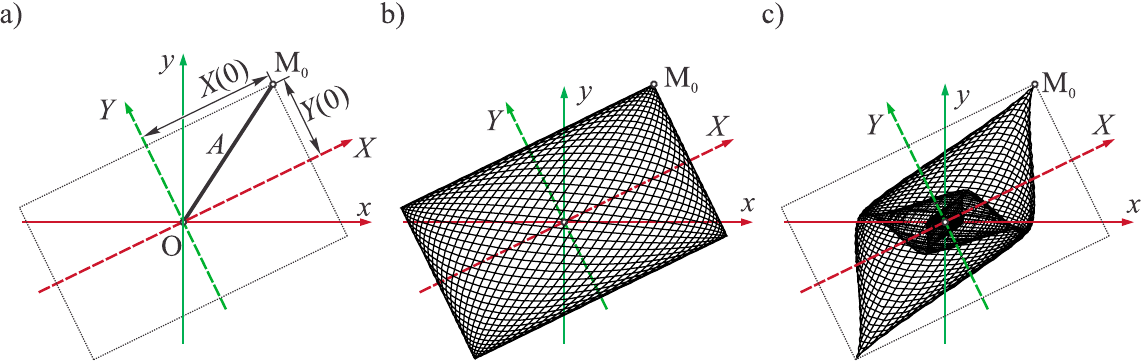
Figure 4. ( a ) Principal axes X and Y , non-principal axes x and y , the initial position M 0 , and the rectangular as the envelope of the trajectory; ( b ) Trajectory of undamped motion; ( c ) Trajectory of damped motion.